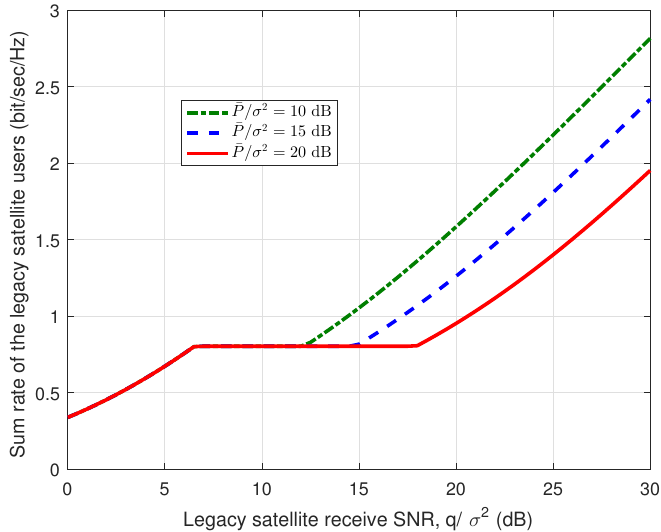
Figure 4. Sum rate of the legacy satellite users vs. legacy satellite receive SNR.